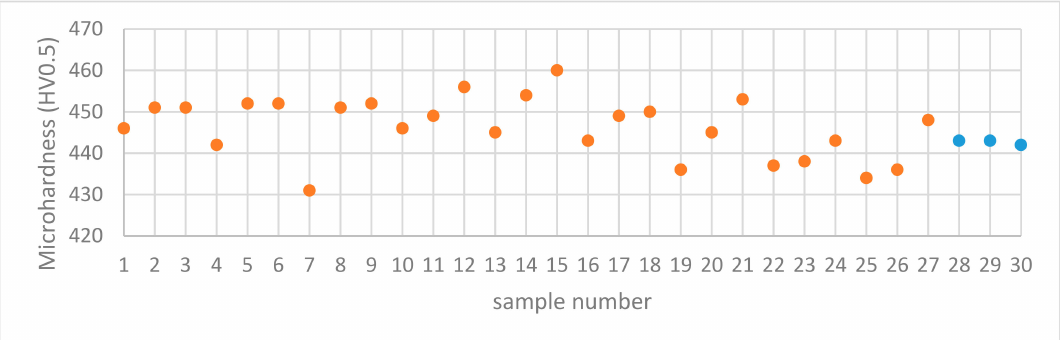
Figure 15. Microhardness of samples manufactured by L-PBF (samples with varied parameters are in orange, while replicates in